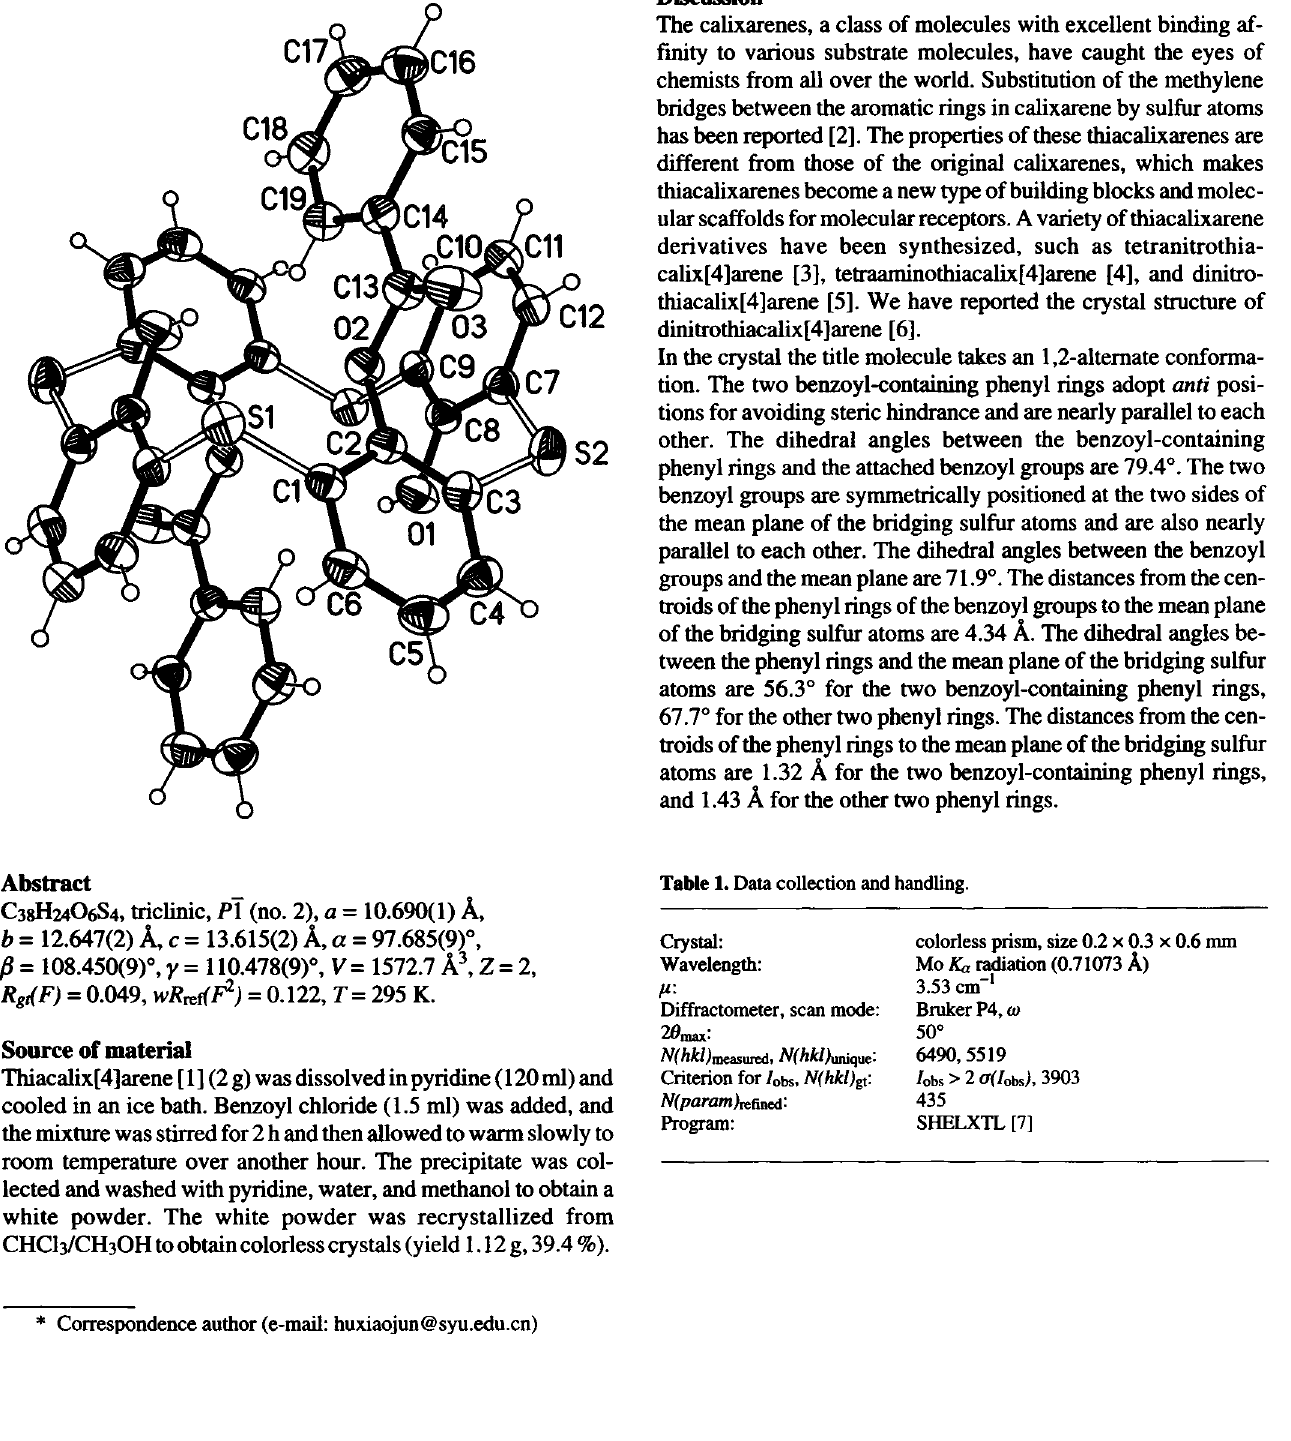
Table 1. Data collection and